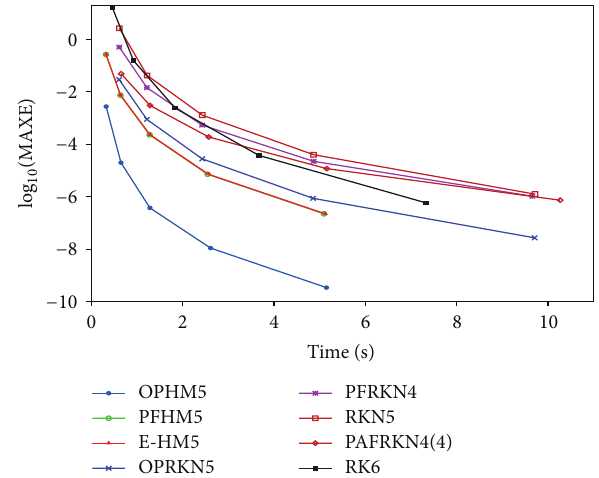
Figure 7: The efficiency curves of the optimized and phase-fitted = order five methods and their comparisons for Problem 8 with 𝑡 end 10 4 and ℎ = 0.125/2 𝑖 , 𝑖 = 1,...,5 .